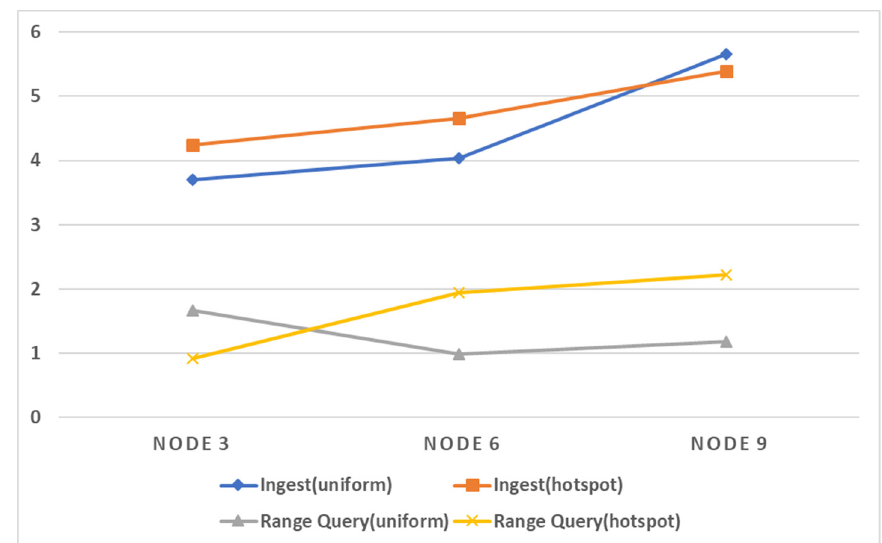
Figure 14. Performance improvement rates of range queries and ingestion of the proposed method compared to Geomesa.